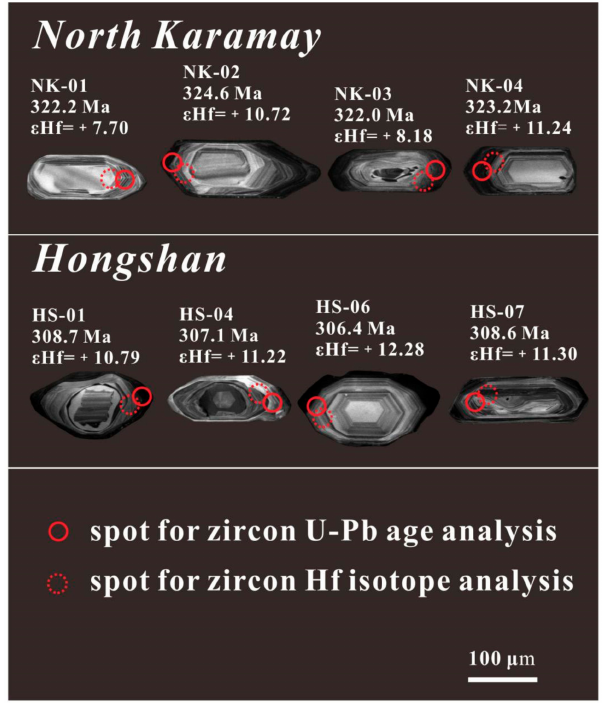
Figure 4. Representative cathodoluminescence (CL) images of zircons for the granitoids in Western